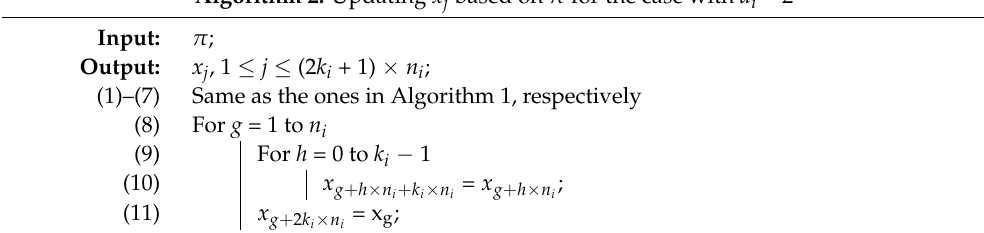
Algorithm 2: Updating x j based on π for the case with d i =